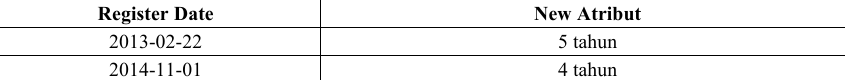
Table 5. Transforming the age of